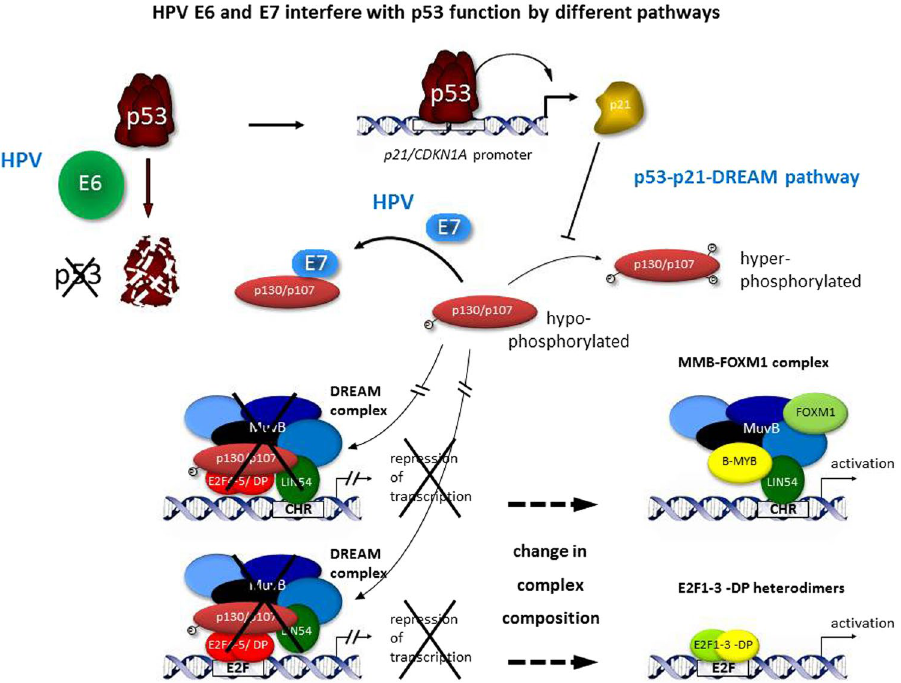
Figure 3. Both HPV E6 and E7 interfere with p53 function. HPV E6-mediated degradation of p53 is well established. By an independent mechanism, the HPV E7 oncoprotein interferes with the p53-p21-DREAM pathway. Interference is caused by the abrogation of indirect p53-dependent transcriptional repression of many genes required for cell cycle progression. E7 sequesters hypo-phosphorylated p130 and p107 proteins, thereby preventing them from forming the DREAM transcriptional repressor complex. In general, DREAM can bind to four combinations of promoter elements: CHR sites, E2F sites, CDE/CHR or E2F/CLE tandem elements 34 . For clarity only genes with CHR or E2F sites are depicted as examples. When p130/p107 pocket proteins are sequestered and not available for DREAM repressor formation, protein complexes on E2F or CHR sites change their composition from repressor to activator complexes. CHR elements then bind MMB-FOXM1 and E2F sites bind activating E2F1-3-DP complexes, respectively. In conclusion, sequestration of p130 and p107 by HPV E7 abrogates p53-dependent repression of cell cycle genes and thus impairs cell cycle checkpoint control by